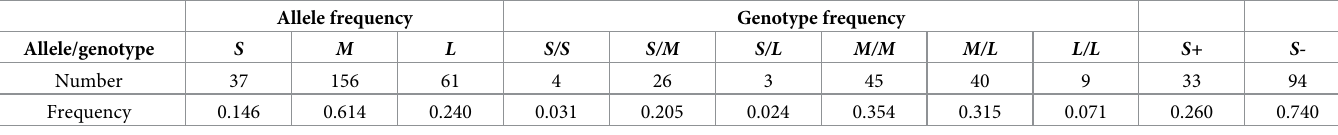
Table 2. Observed numbers and frequencies of LDHA alleles and genotypes.